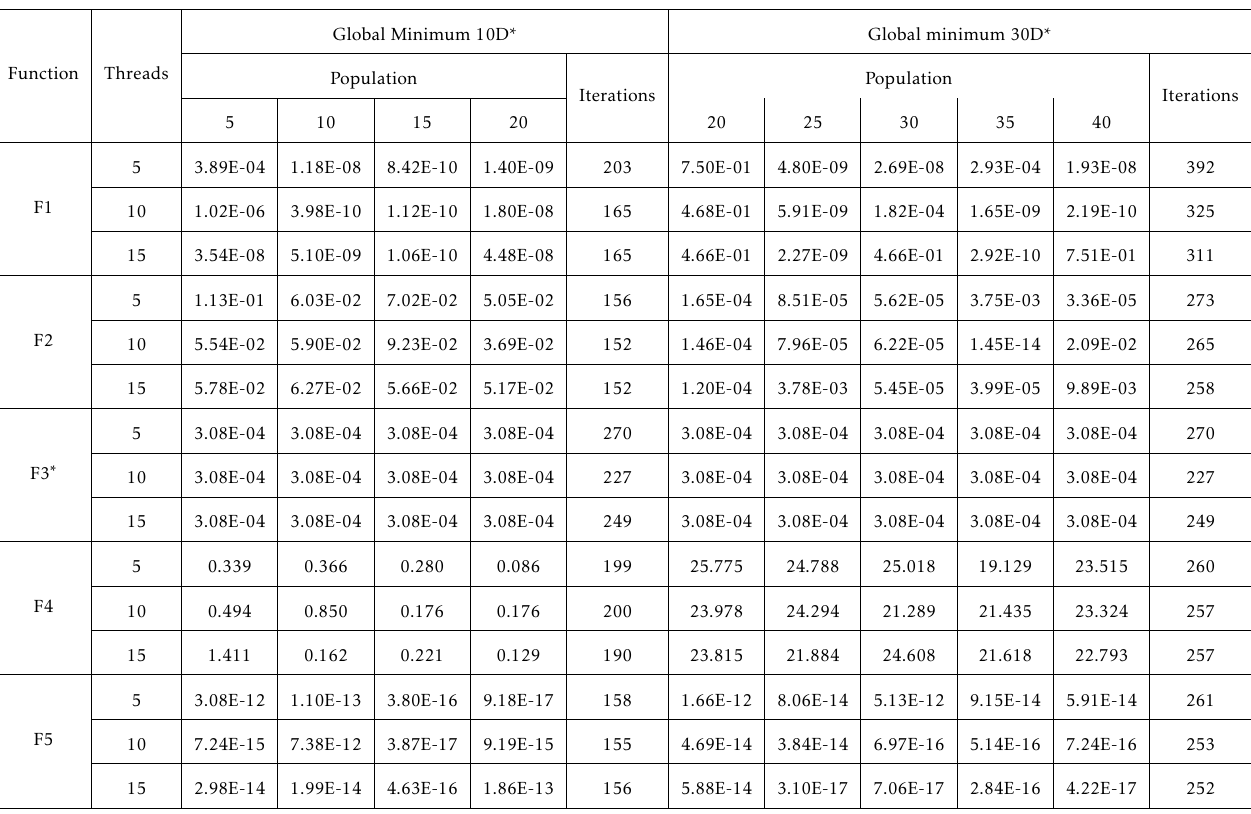
Table 8. RFO performance results in parallel with genetic restart to the best method